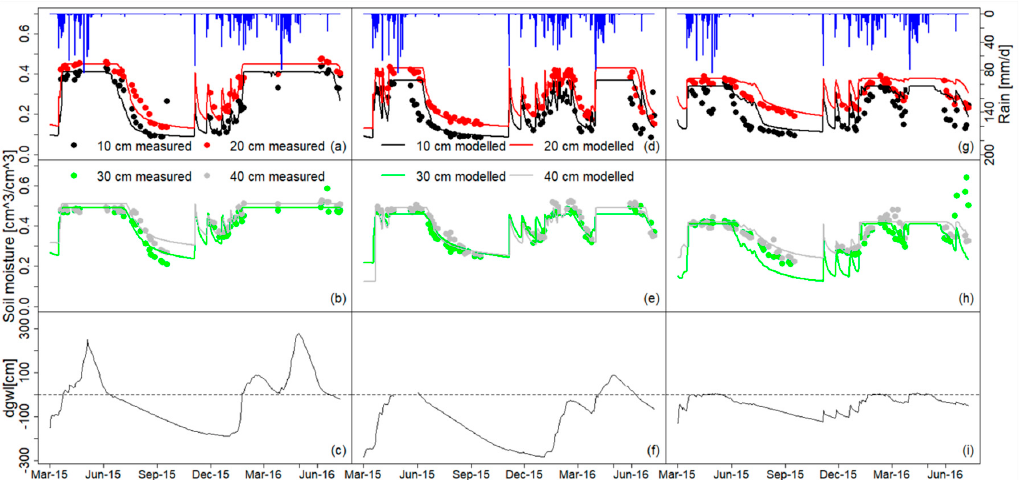
Figure 6. Comparison of measured (averaged from all plots) and modeled soil moisture from the averaged calibrated hydraulic parameters at each hydrological zone. ( a – c ) Riparian zone; ( d – f ) middle zone; ( g – i ) fringe zone. dgwl: measured depth to groundwater level.